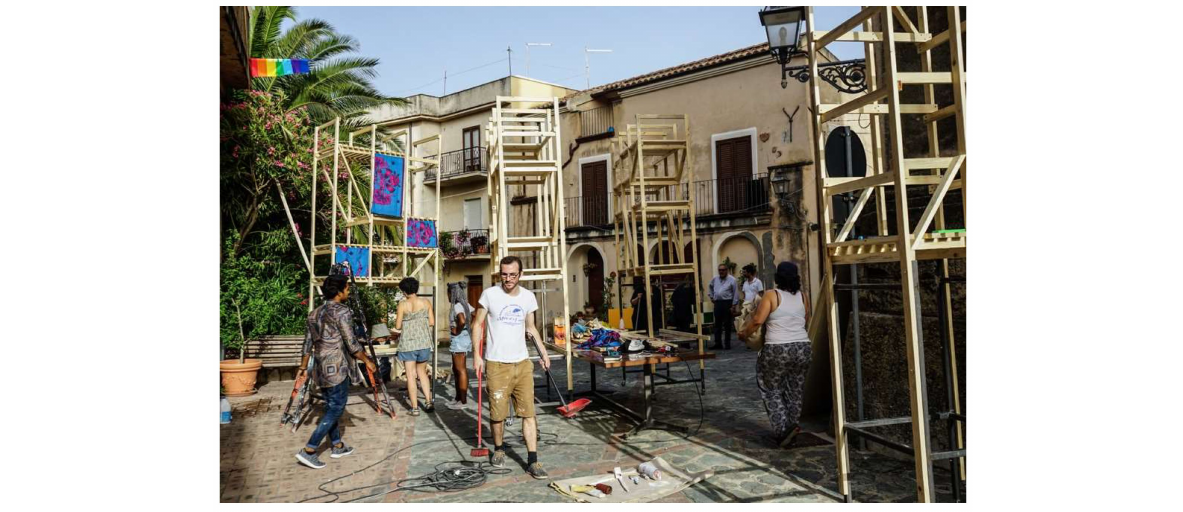
Figure 3. Construction of mobile shelving towers in 2018 (Source: photograph by Silvia Gin and Zeshan